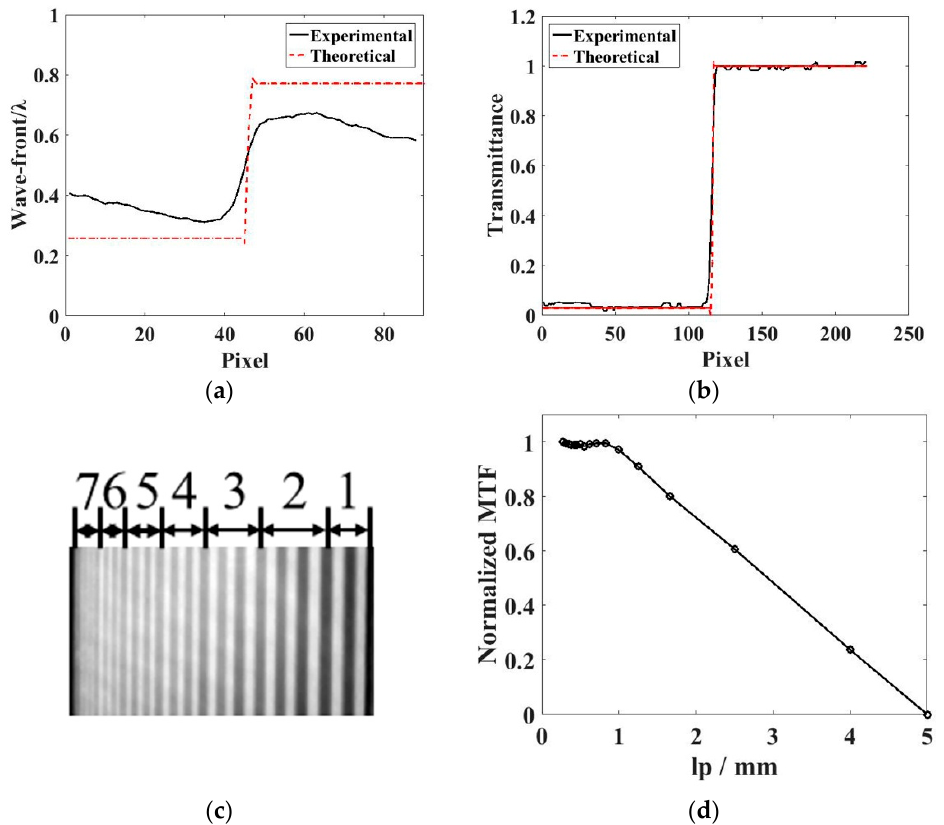
Figure 8. Modulation results of grayscale map with value mutation. ( a ) 1D wave-front. ( b ) 1D transmittance. ( c ) The modulated result obtained by CCD when the spatial-light modulator (SLM) is loaded with a binary image of varying variable periods. 1, 760 µm; 2, 520 µm; 3, 440 µm; 4, 320 µm; 5, 240 µm; 6, 200 µm; 7, 120 µm. ( d ) Modulation transfer function (MTF) of the OASLM as a function of spatial resolution.